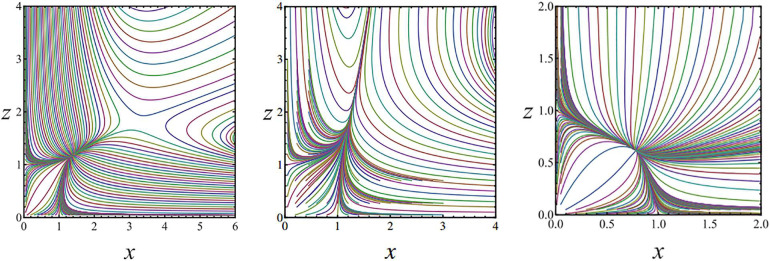
Phase diagrams of symbiotic systems with different symbiotic parameters.(a) Stable degradation node and saddle point phase diagram. (b) Stable degradation node phase diagram. (c) Stable nodal phase diagram.